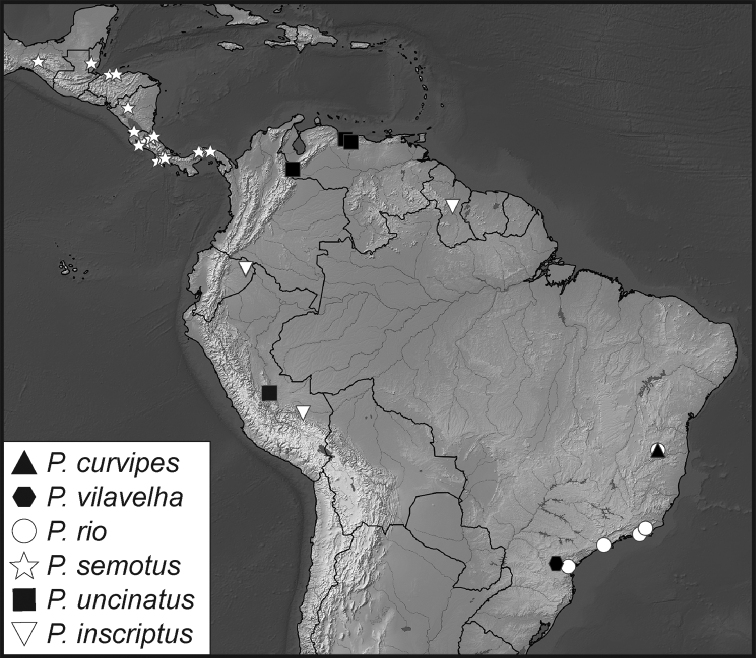
Collecting records for Phelister
curvipes (upright black triangle), P.
vilavelha (black hexagon), P.
rio (white circle), P.
semotus (stars), P.
uncinatus (black squares), and P.
inscriptus (inverted white triangles).